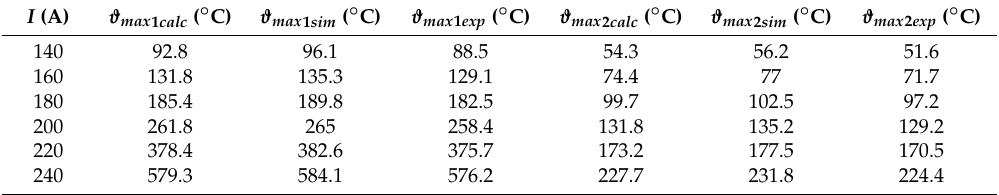
Table 2. Computed, simulated and experimental temperature rise according to the Figure